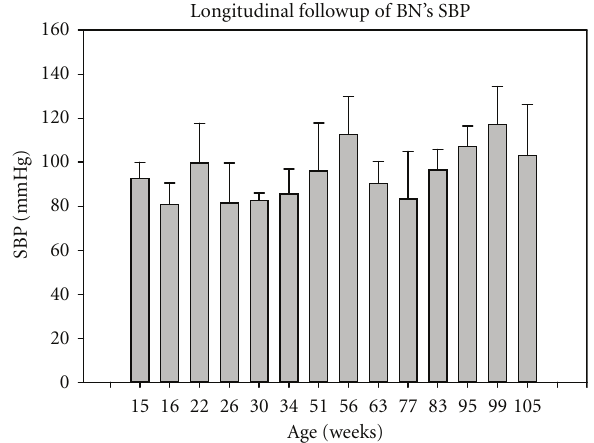
Figure 3: Follow-up of BN’s SBP as a function of aging. By remov- ing SBP values at 56 and 99 weeks old, no significant change in SBP was observed, P = 0 . 108.